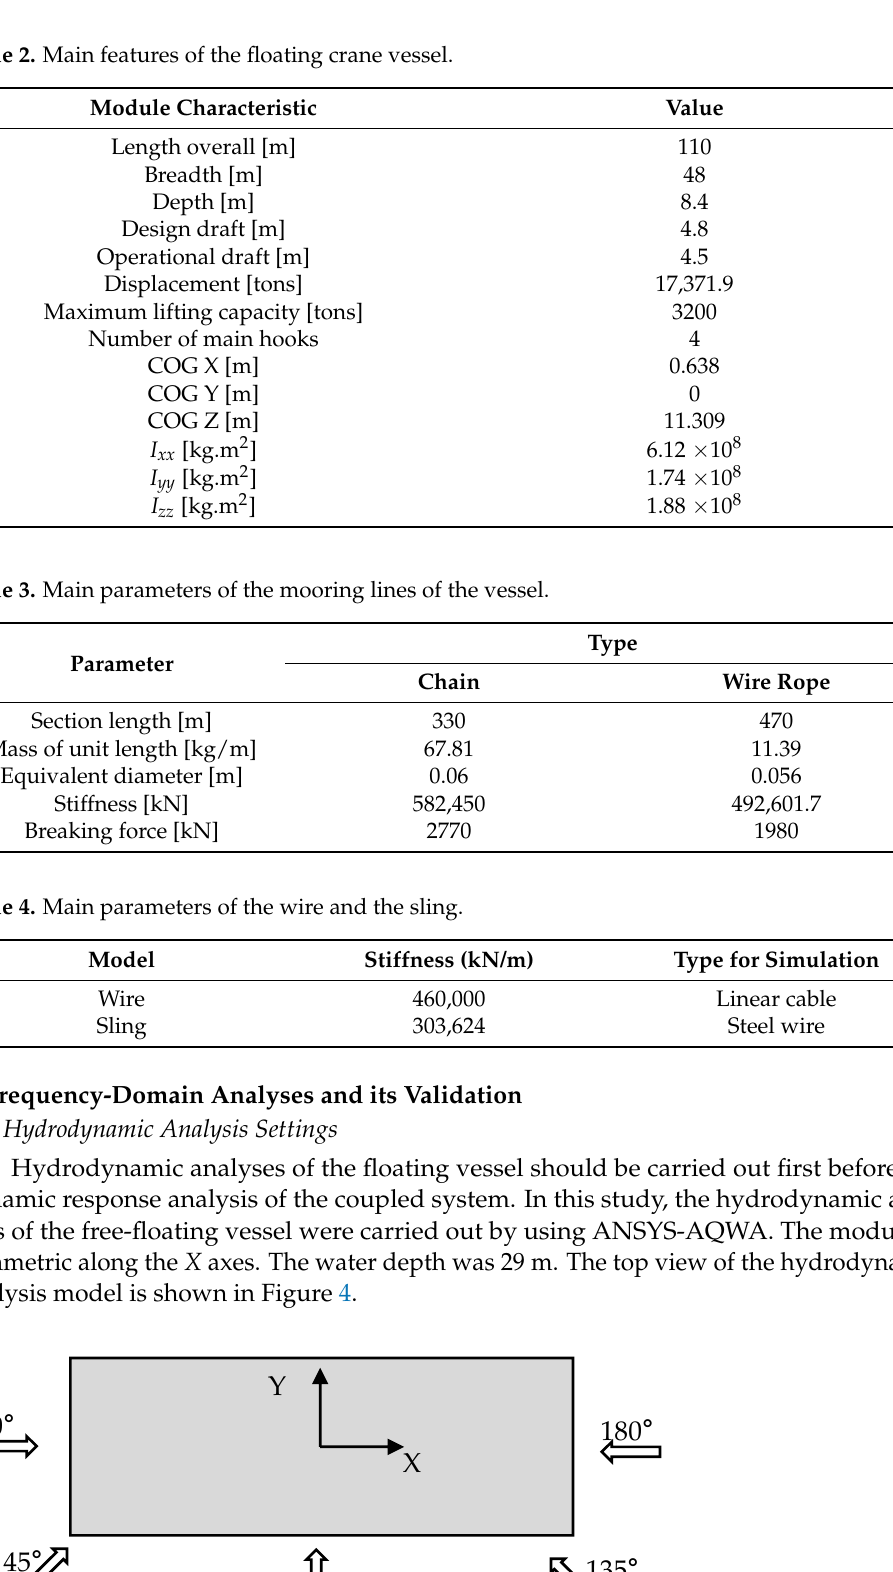
Table 2. Main features of the floating crane vessel.